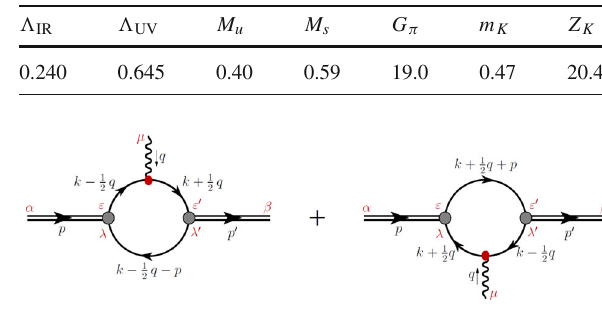
Fig. 2 Kaon GPDs